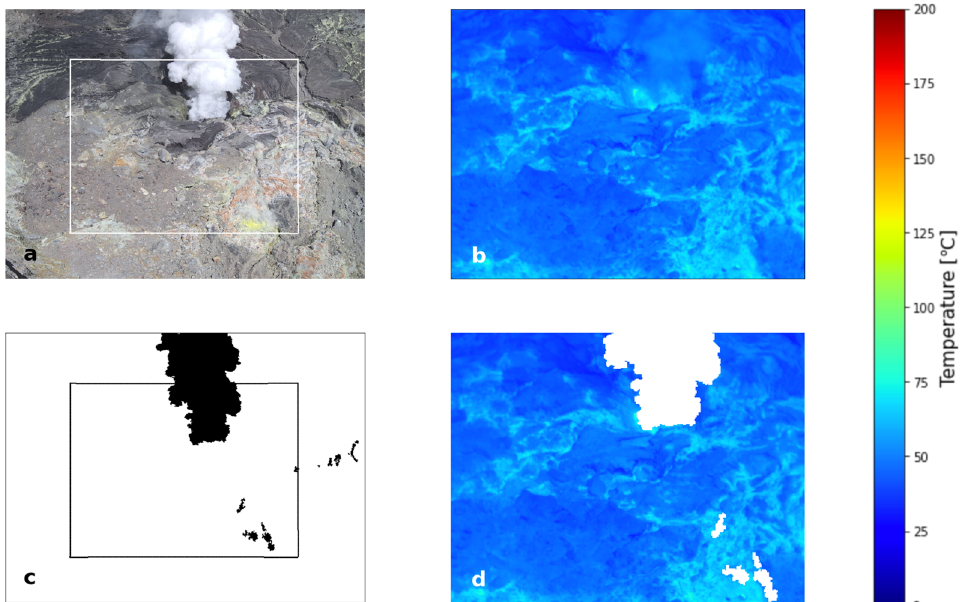
Fig. 1 Image samples acquired with XT2 and used in the masking process. a and b Visible image of the active crater at Aso volcano in 2020, and its paired TIR image. c Area of the condensed vapor on the visible image determined by the software (Agisoft Metashape Professional). d TIR image overlapped with the masking image. The white area corresponds to the black area in c . The white and black rectangles on a and c indicate the area corresponding to the TIR image shown in b